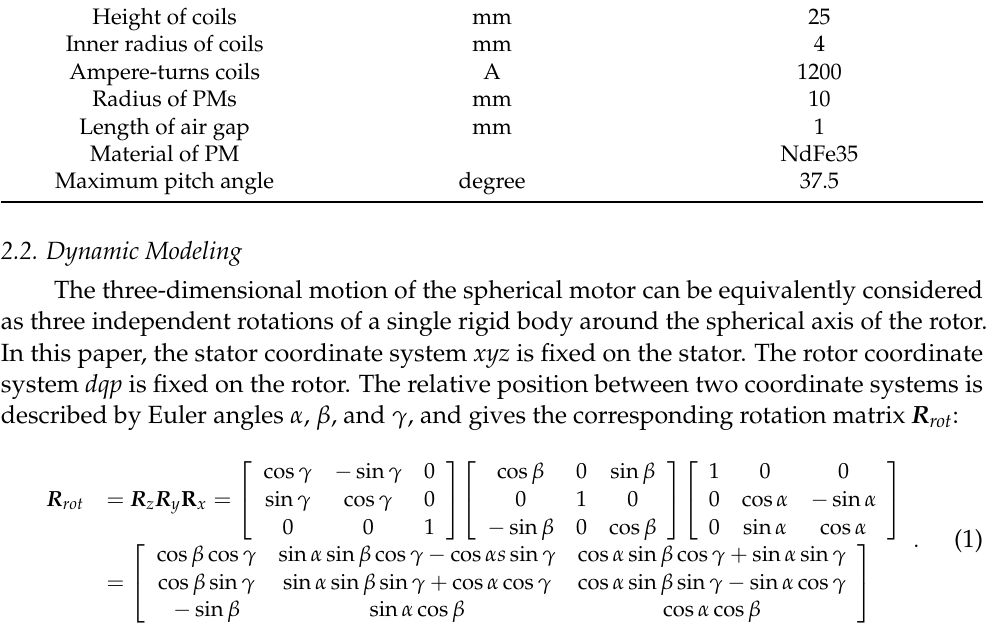
Table 1. Specifications of the PMSpA. Parameters Unit Radius of the